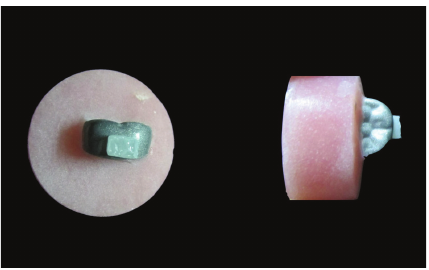
Figure 1: Stainless steel crown bonded to composite, mounted in an acrylic resin